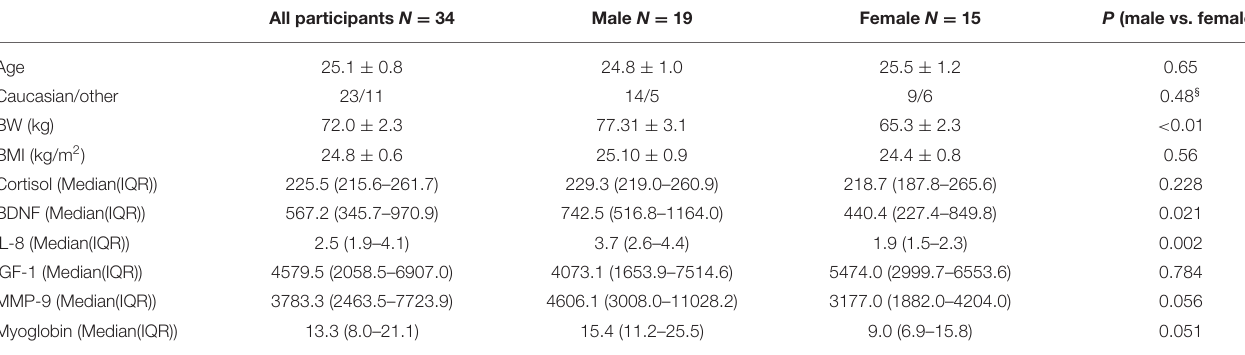
TABLE 1 | Baseline parameters (T1) in all, male, and female participants. All participants N = 34 Male N = 19 Female N = 15 P (male vs. female)